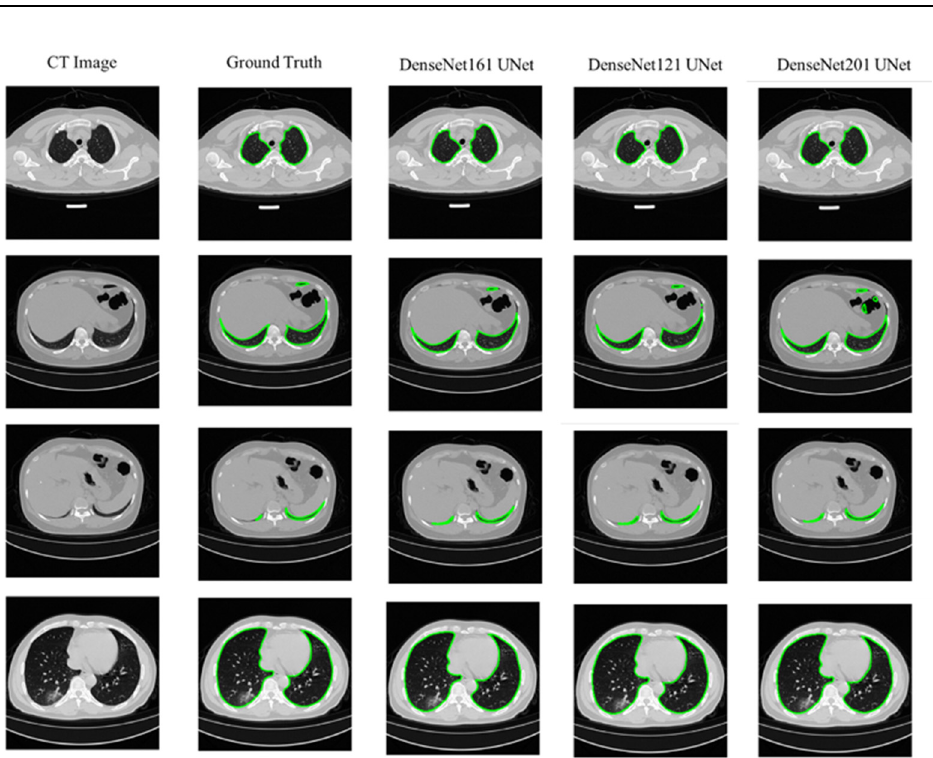
Figure 4. CT image (1st row), ground truth (2nd row), and the segmentation masks of the top three networks (rows 3–5).